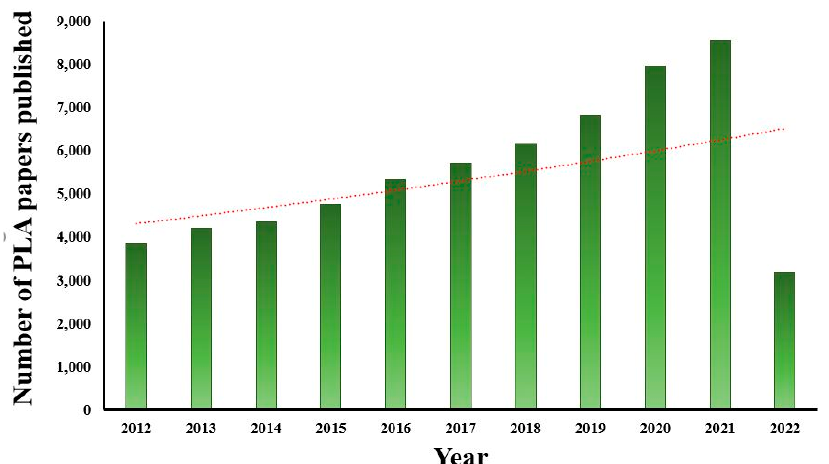
Figure 1. Number of papers published in PLA-based composites (through April 2022) (data collected from Web of Science).